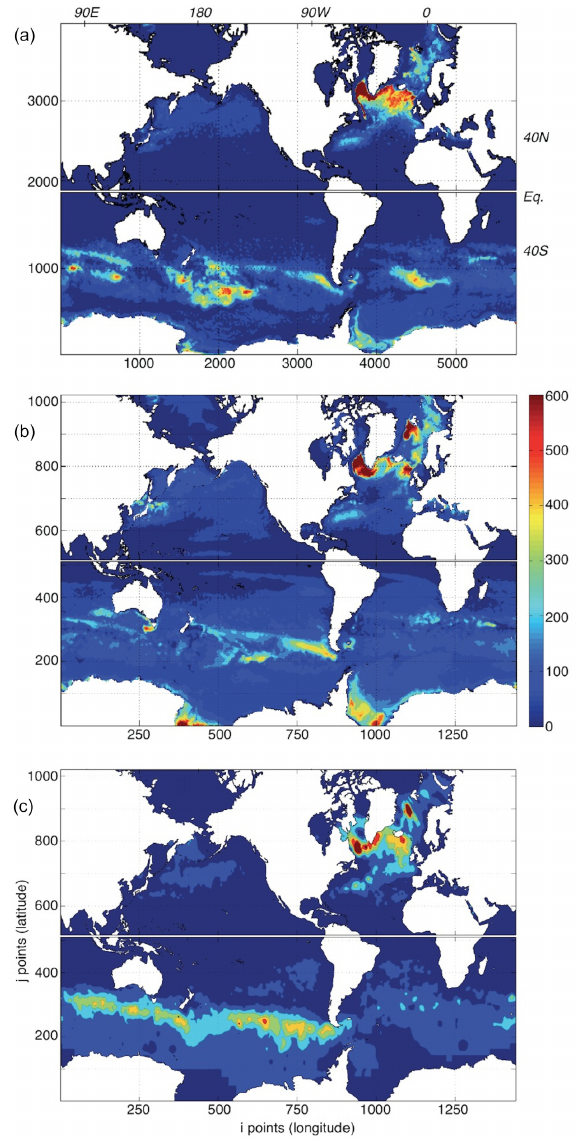
Figure 6. Mixed layer depth (in metres) averaged over March (in the Northern Hemisphere) and September (in the Southern Hemi- sphere) 2009–2013 from (a) GLOB16, (b) GLOB4, and (c) the de Boyer Montégut et al. (2004) climatology, based on a 0.03 thresh- old on density profiles. Model outputs are shown on the native grid; observations are interpolated on the eddy-permitting ORCA grid. Numbers of grid points are indicated on the axis, along with indica- tions of latitudes and